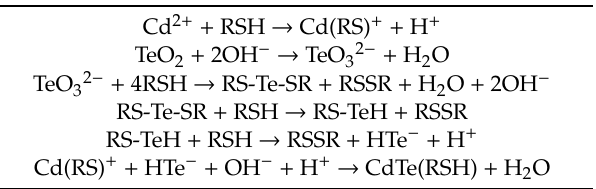
Table 1. Expected scheme of synthesis of cadmium telluride quantum dots (CdTe QDs) using 3-mercaptopropionic acid (MPA =